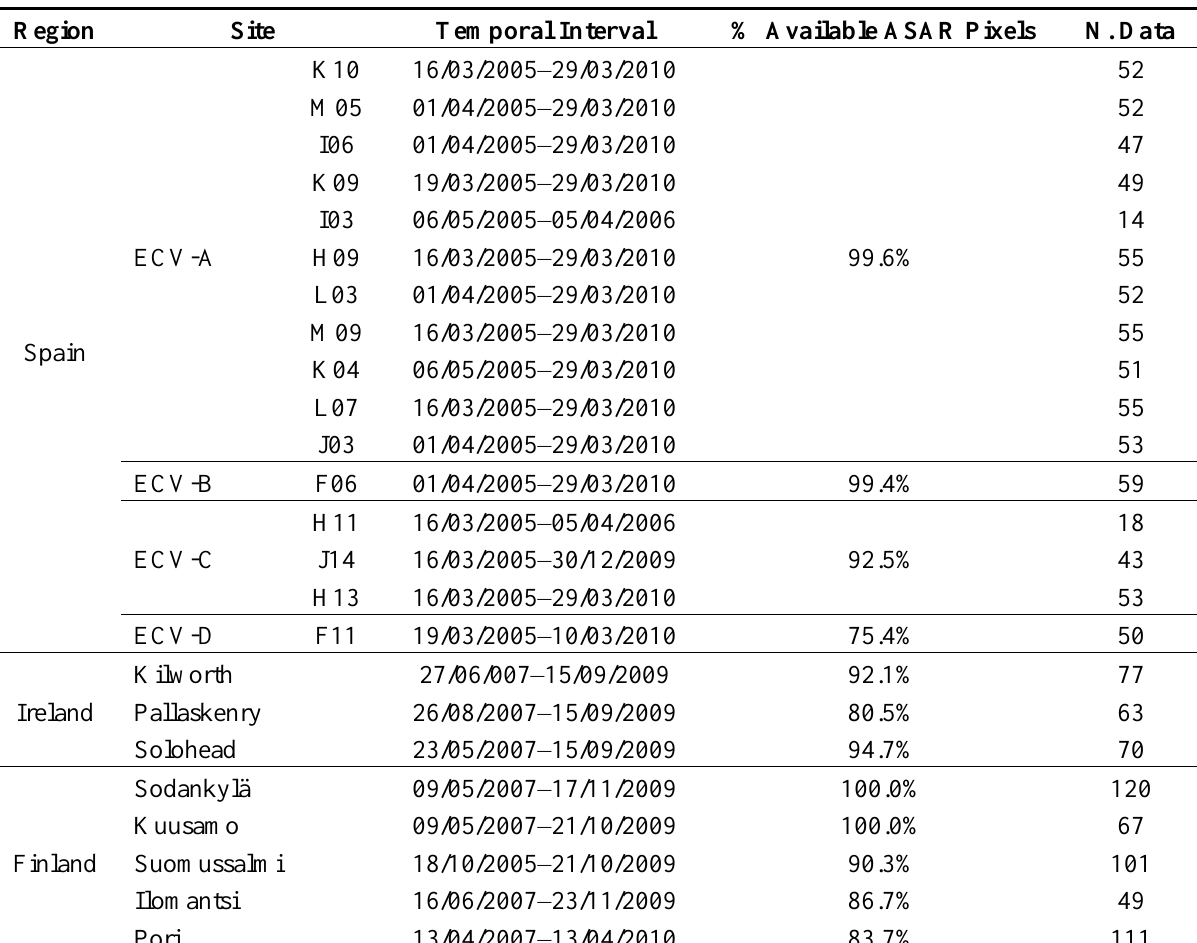
Table 4. Number of ASAR WS acquisitions temporally compatible with the ECV and in situ soil moisture data at each site. For each ECV cell, it is also shown the percentage of corresponding ASAR pixels (1 km × 1 km after resampling) still available after the land cover and correlation based masking